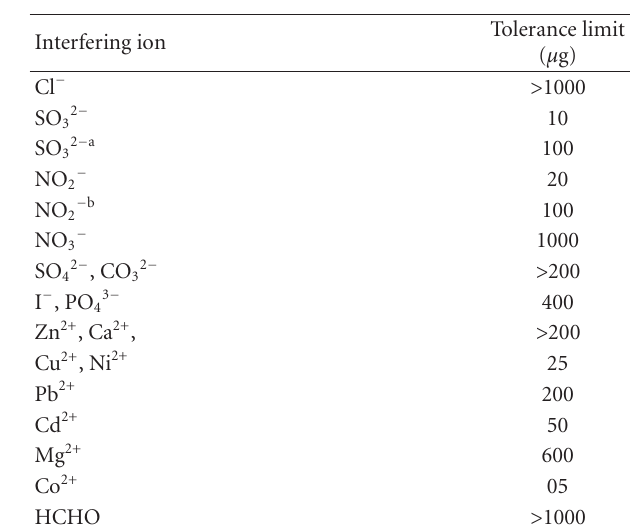
Table 2: Interference